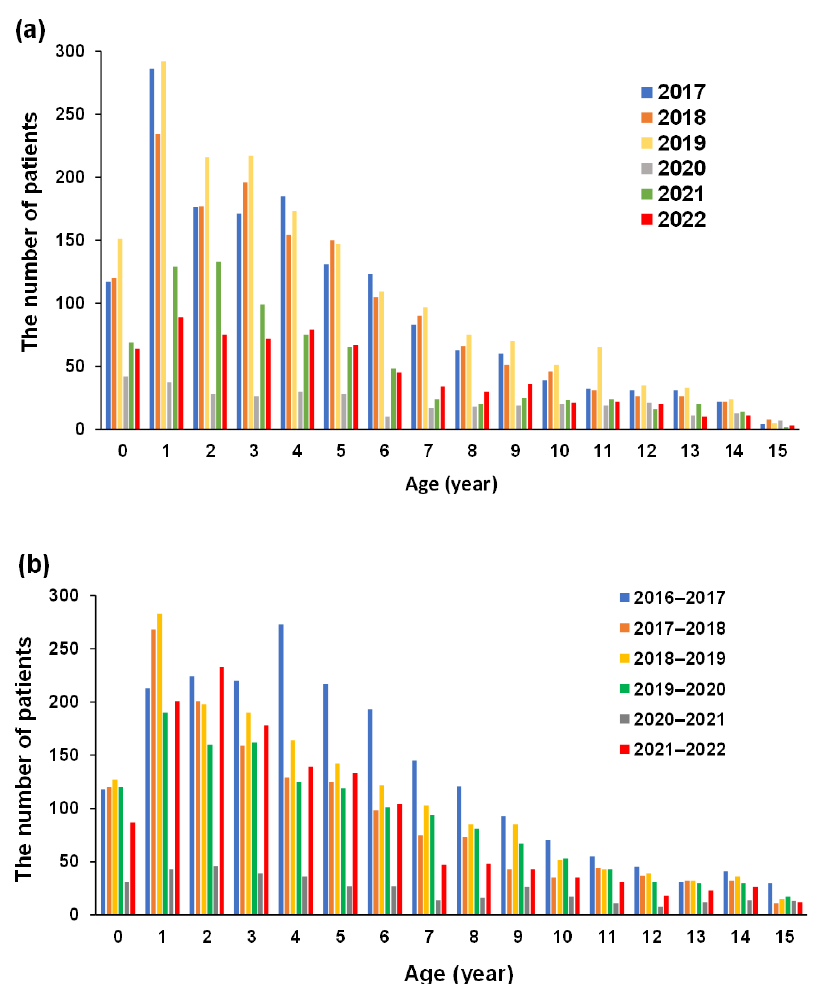
Figure 3. Changes in the annual number of patients with AGE according to age during RV ( a ) and NV ( b ) Scheme 2016 and ended in June 2022, the data for 2016 during the RV season are not shown. AGE, acute gastroenteritis; RV, rotavirus; NV, norovirus.